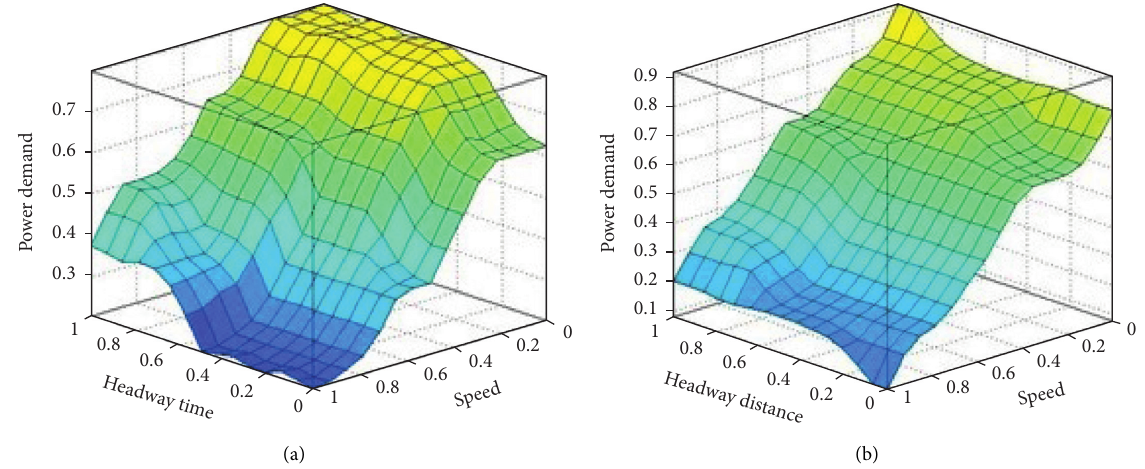
Figure 3: Control surface for each rule set. (a) Time based. (b) Distance based.